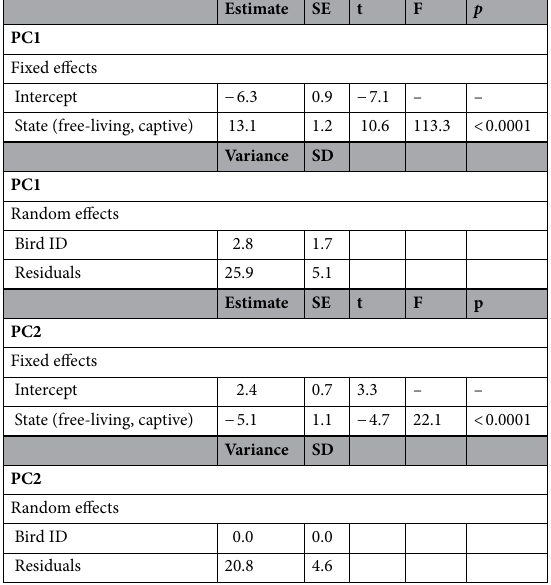
Table 2. Results of linear mixed effects models using factor scores from the first two principal components of PCA to test for differences in uropygial gland microbiota among free-living and captive song sparrows, using bird ID as a random effect to account for birds that were sampled twice: an initial (free-living) sample collected on the day of capture and a captive sample collected after approx. 11 months in captivity (see Table S3 for factor loadings).